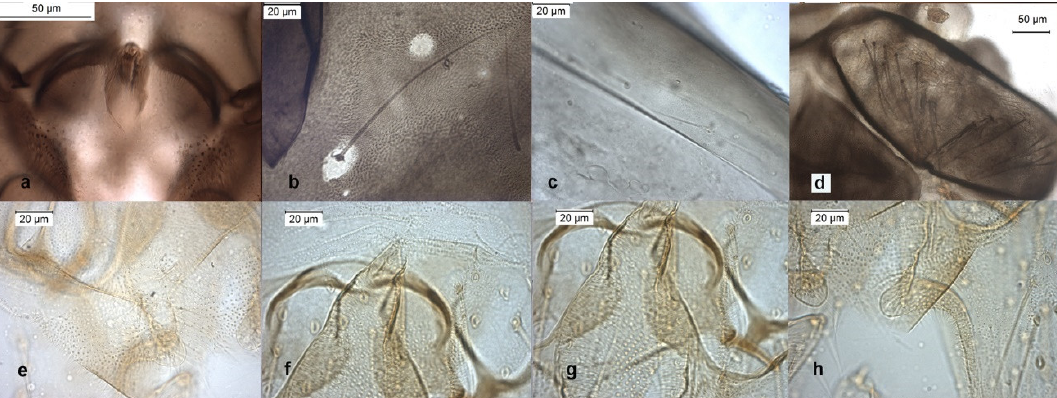
Figure 10. Morphological characters of adult males: ( a ) O. excavatus virga, ( b ) O. excavatus dorsocentral setae, ( c ) O. rubicundus dorsocentral setae, ( d ) O.O. wetterensis scutellum, ( e ) O.S. ruffoi anal point, ( f ) O.S. ruffoi virga, ( g ) O.S. ruffoi superior volsella, ( h ) O.S. ruffoi inferior volsella.